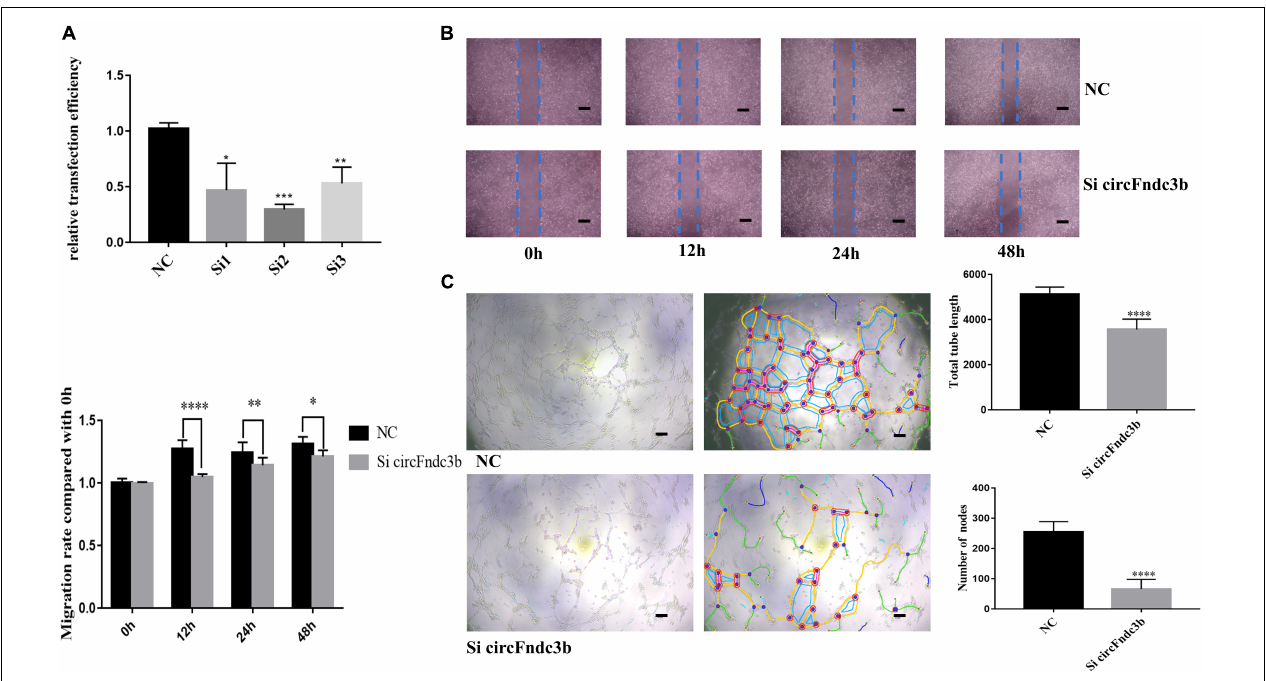
FIGURE 7 | Function of circFndc3b in angiogenesis in vitro . (A) Small interfering RNA 2 had the greatest interference efficiency. (B,C) circFndc3b knockdown can reduce the migration (B) and tube formation ability (C) of endothelial cells (ECs) in comparison to the negative control. Representative images of wound healing and tube formation are shown along with quantitative data ( n = 3). Scale bar , 100 µ m. * P < 0.0332, ** P < 0.0021, *** P < 0.0002, **** P <